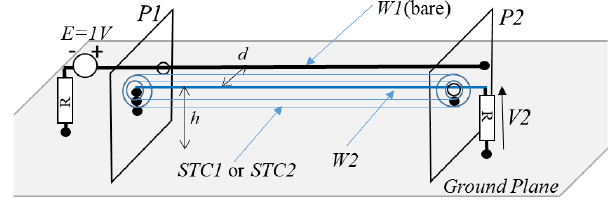
FIGURE 16. Scheme of the Shielded Test Cable installation. The black dots figure perfect connections; the absence of black dots figure the possibility of imperfect connections.